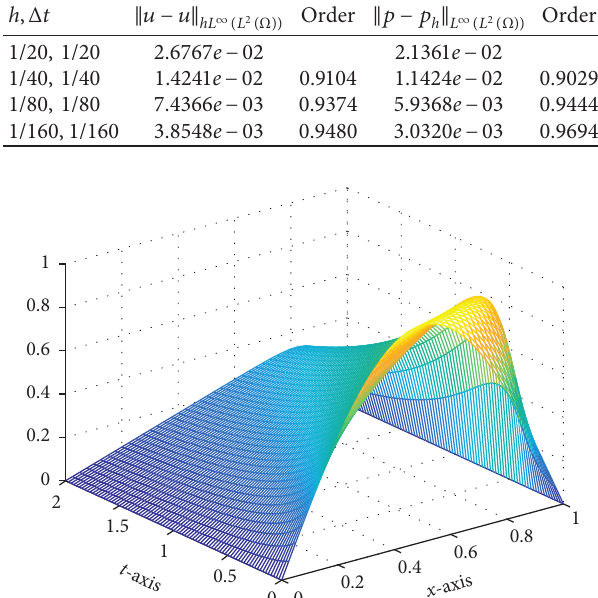
Figure 1: Graph of the exact solution of u ( x,t ) at t � 2 with h � 1/40.